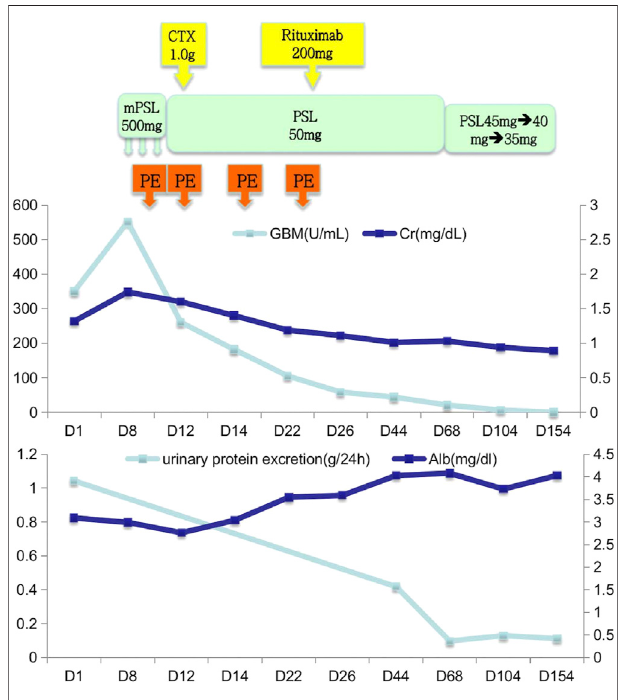
FIGURE 4 | Clinical course. PSL: prednisolone, CTX: cyclophosphamide, PE: plasma exchange.